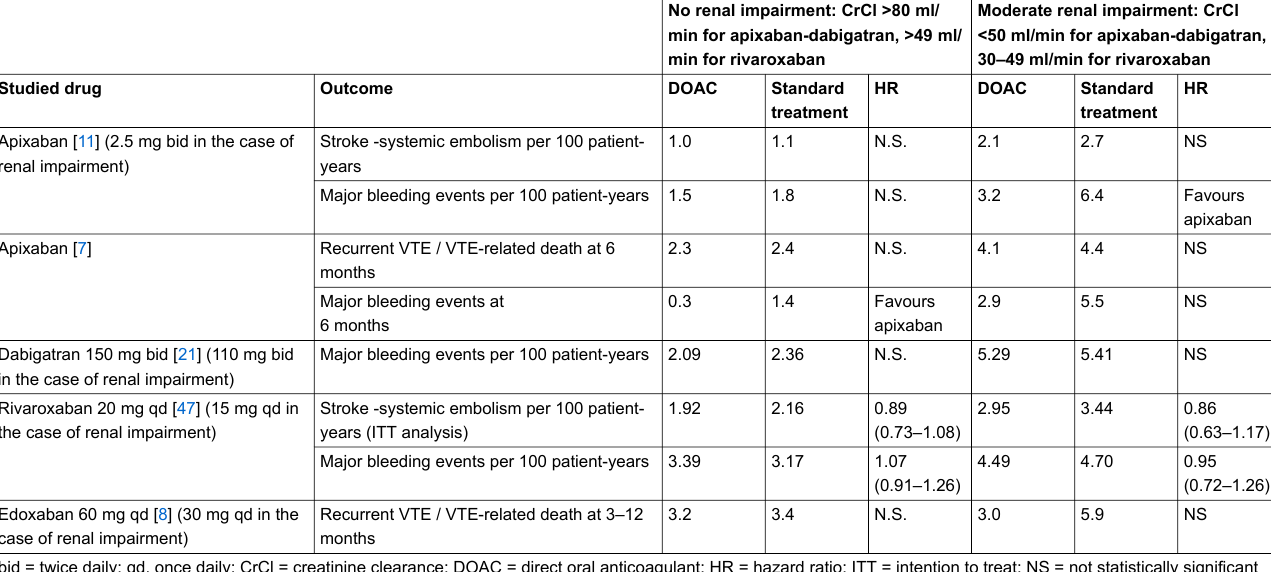
Table 4: Efficacy and safety of direct oral anticoagulants in patients with moderate renal impairment versus normal renal function. Direct comparison of outcomes between different drugs is discouraged, as definition of moderate renal impairment is not uniform throughout the different studies.